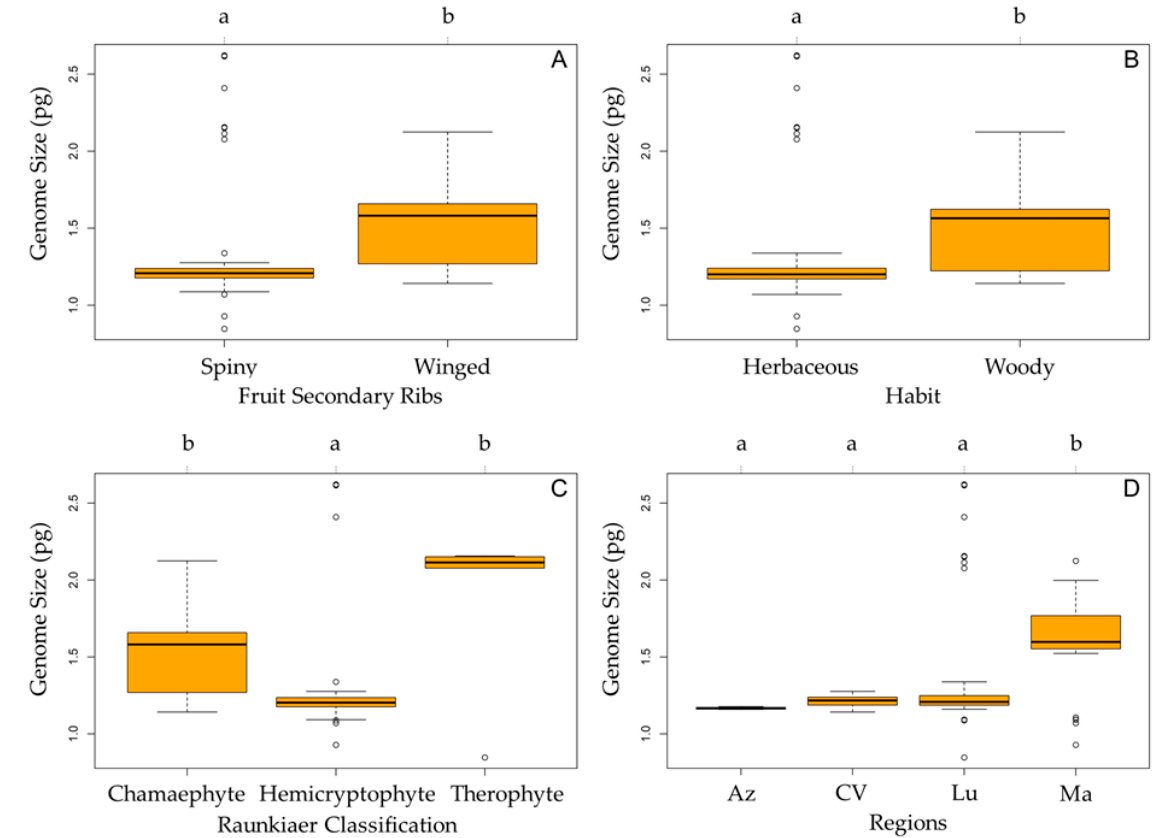
Figure 4. Boxplot diagram showing the genome size variation for the studied Daucinae taxa according to ( A ) morphology of the secondary ribs (winged or spiny), ( B ) habit (herbaceous or woody), ( C ) Raunkiaer classification (chamaephyte, hemicryptophyte, or therophyte), and ( D ) regions (Az, Azores; CV, Cabo Verde; Lu, Portugal mainland; and Ma, Madeira). The orange box represents the 25th, 50th (median), and 75th percentiles, while whiskers represent the 10th and 90th percentiles with minimum and maximum observations. The dots represent the outliers. Different letters indicate significant differences between groups ( p < 0.05).